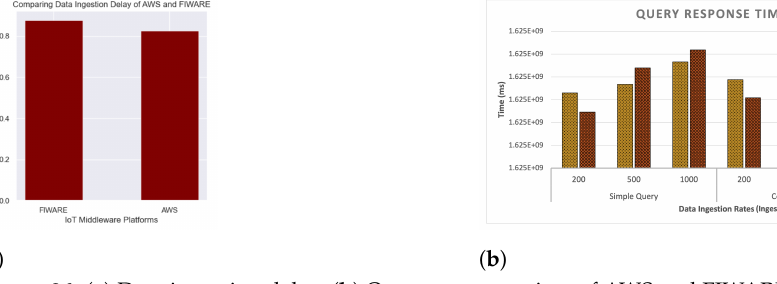
Figure 26. ( a ) Data ingestion delay. ( b ) Query response time of AWS and FIWARE